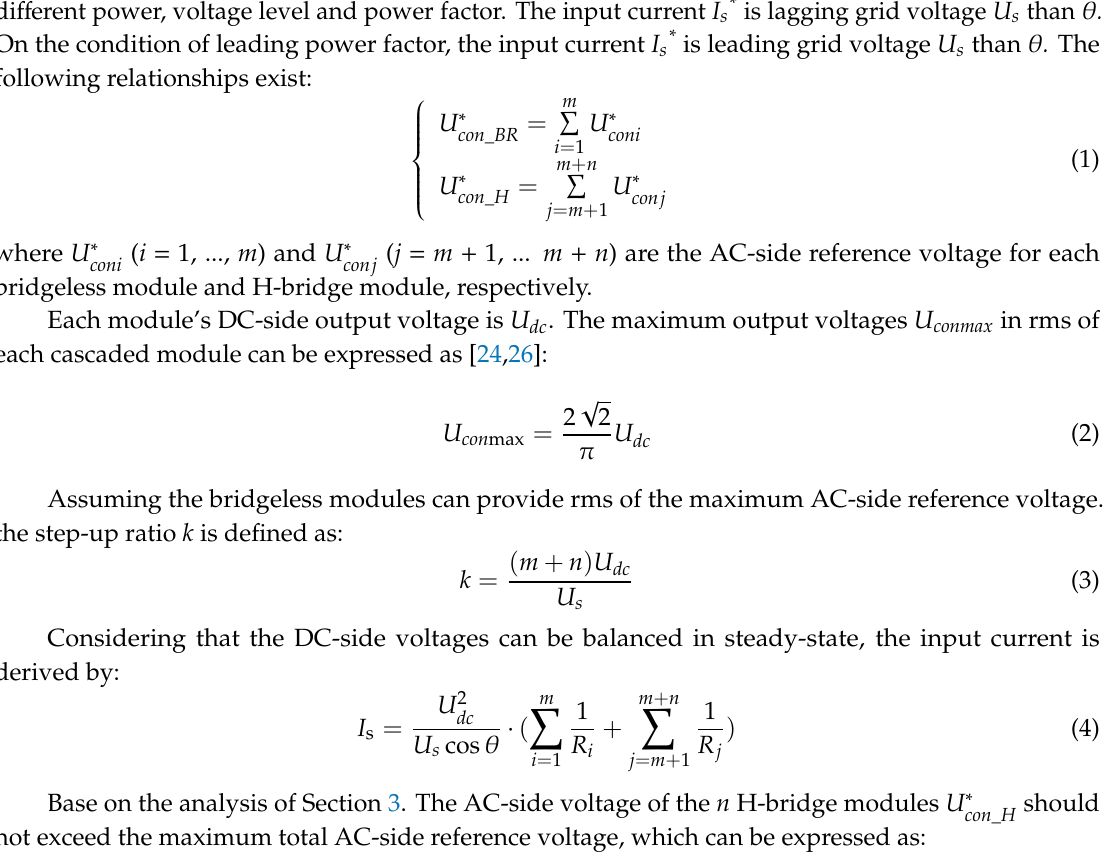
Figure 3. Single-phase hybrid cascaded rectifier under the steady-state. ( a ) AC-side phasor diagram under the premise of U ∗ con _ BR lags I s * ; ( b ) revised AC-side phasor diagram under the premise of * _ con BR U in phase with I s * ; ( c ) AC-side waveforms.